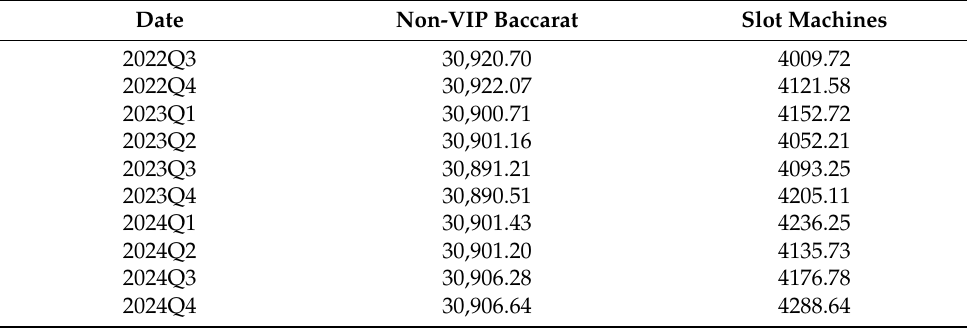
Table 4. Forecasting results of the Non-VIP segments (in